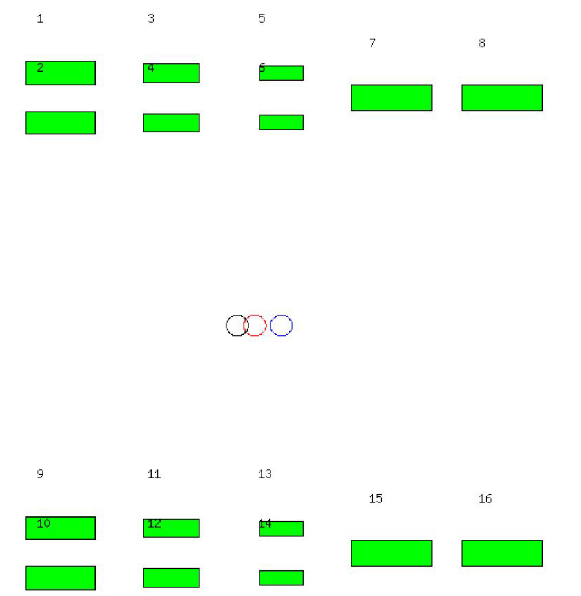
Figure 8. Spatial configuration of the array of air-guns mounted in the vessel “Sarmiento de Gamboa” used in the generation of the ac- tive seismic signal during the WAS campaign. Circles represent the theoretical position of the highest energy bubble obtained with this array of